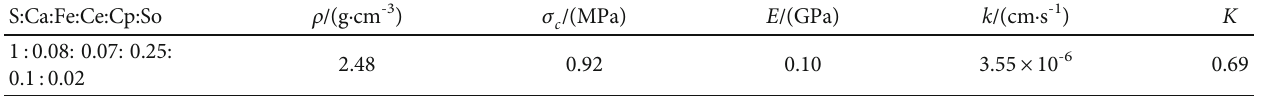
Table 1: Mix proportion of surrounding rock similar materials and its basic parameters.